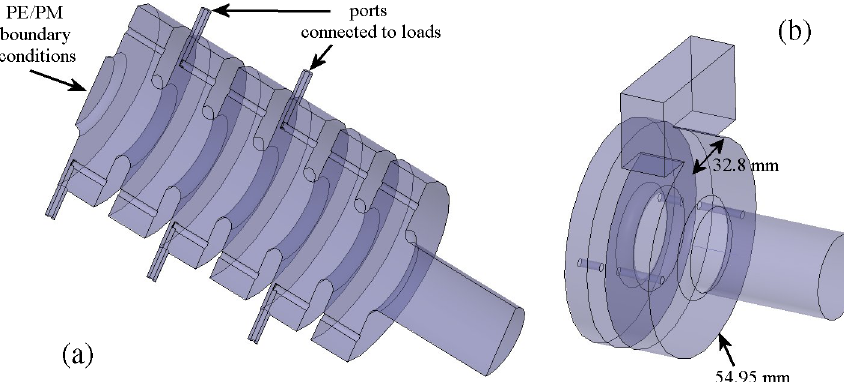
FIG. 13. HFSS geometries: (a) simulated structure to find the quality factor of the vertical modes; (b) coupler detail with dimensions.